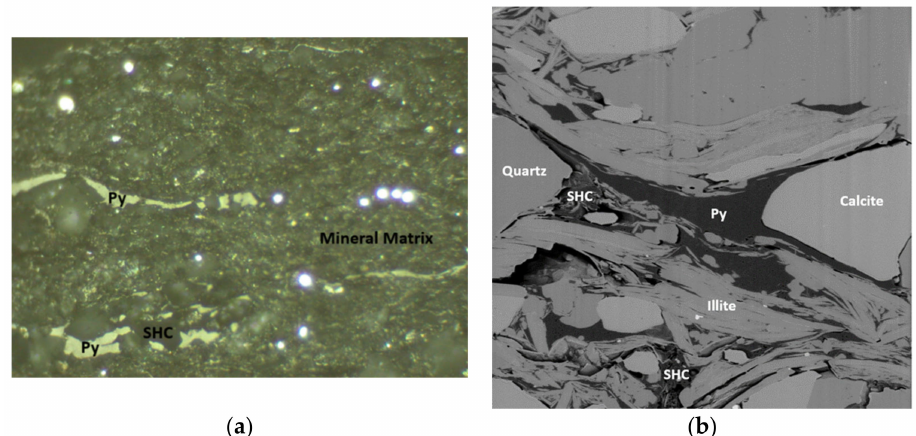
Figure 4. ( a ) Whole rock photomicrograph of pyrobitumen (Py) lenses and angular fragments, solid hydrocarbon (SHC), and mineral matrix in overmature (VR o = 4.56%) Marcellus Formation recovered in the Bennett #1 well, Sullivan County, Pennsylvania. ( b ) Backscatter electron (BE) SEM photomicrograph of the same sample. From Laughrey et al. [12].